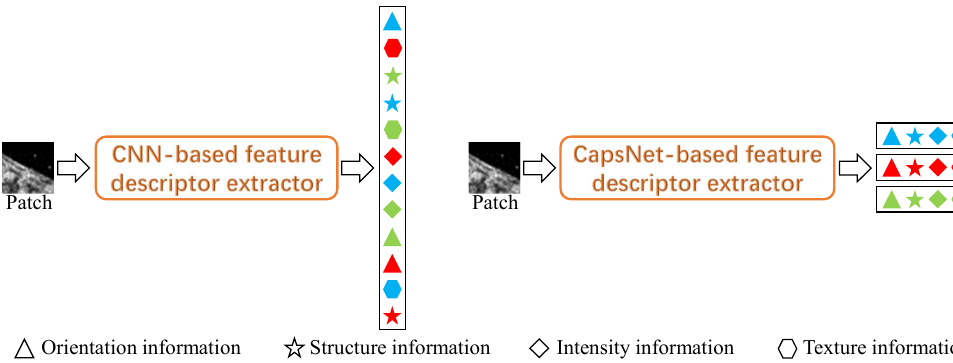
Figure 6. Illustration of the difference between two types feature descriptors. (The different shapes represent different types of information, and the different colors represent different